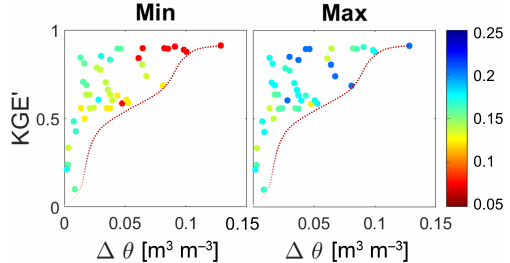
Figure 9. Performance of CRS soil water content data derived from two-point calibrations in relation to difference between soil mois- ture states ( (cid:49)θ ) at the two calibration dates. The color bar indicates volumetric soil water content. Left panel: points are colored ac- cording to the soil water content of the drier calibration date. Right panel: points are colored according to the soil water content of the wetter calibration date. Dashed lines indicate that soil moisture dif- with sub-optimal conversions of neutron counts to volumetric soil water content.